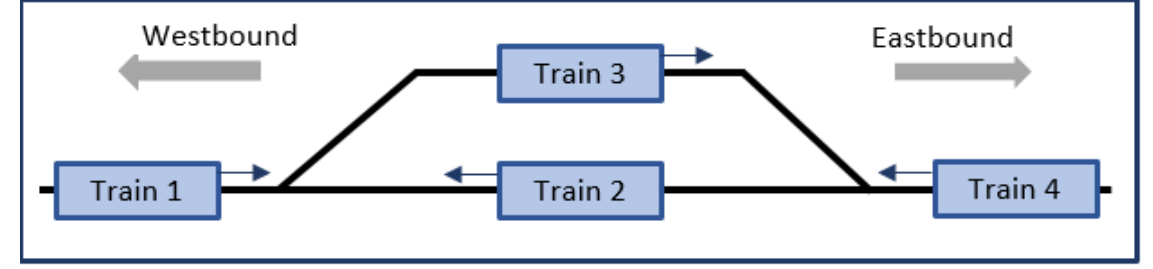
Figure 1. Illustration of deadlock prevention.